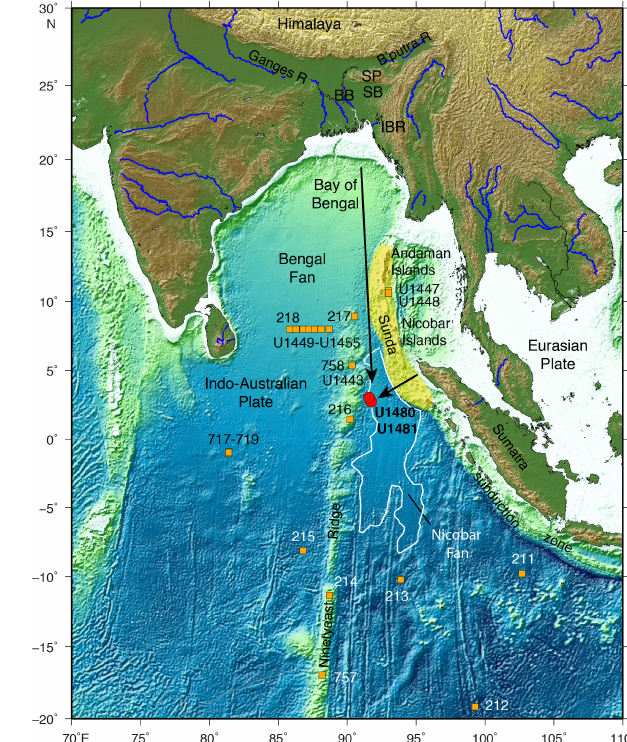
Figure 1. Eastern Indian Ocean map showing the IODP Expedi- tion 362 drill sites (red dots) and the extent of the Nicobar Fan (white line). The yellow shaded area indicates the rupture area of the 2004 Sumatra–Andaman subduction earthquake. The wood could have originated from the north as part of the Bengal–Nicobar Fan transport or from the islands of the Sunda subduction zone to the northeast and east; this includes a possible tsunami transport origin triggered by a northern Sunda subduction zone earthquake, sim- ilar to the 2004 Sumatra–Andaman event (black arrows indicate possible pathways). Map uses GEBCO bathymetric data from the GEBCO_08 Grid data set obtained from the National Centers for Environmental Information (NCEI; previously NGDC). After Mc- Neill et al. (2017a).